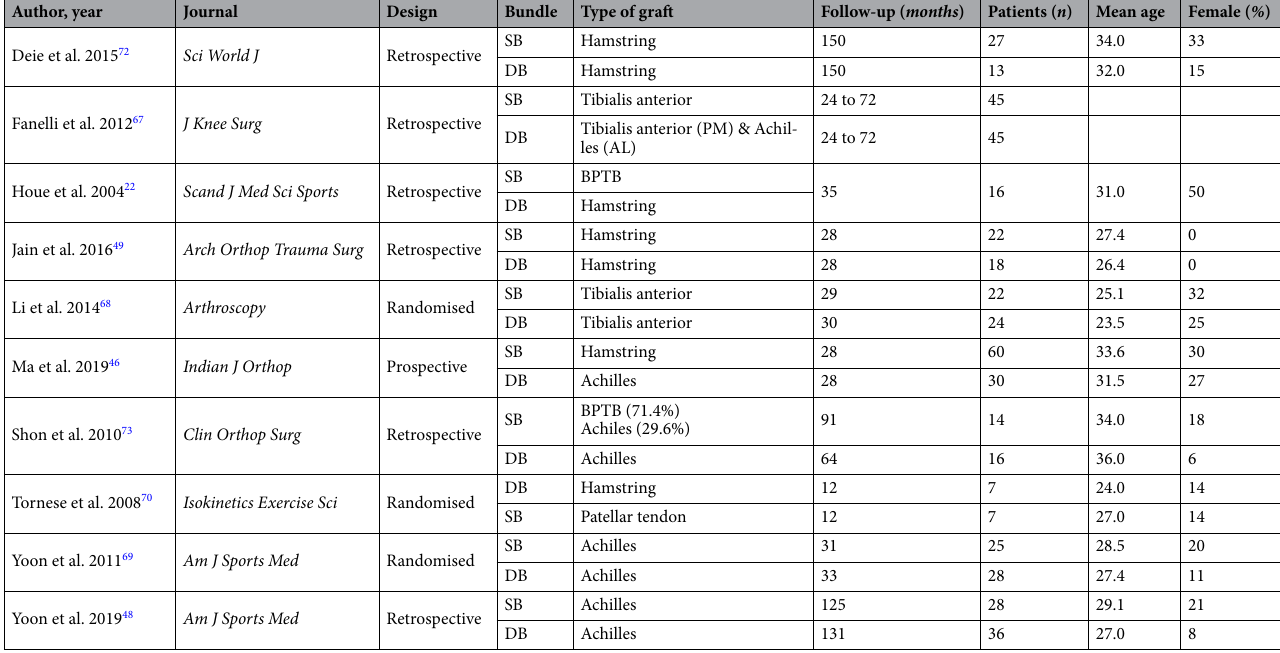
Table 2. Generalities and baseline characteristics of the included studies. PM posteromedial, AL anterolateral, BPTB bone-patellar-tendon-bone, SB single bundle, DB double